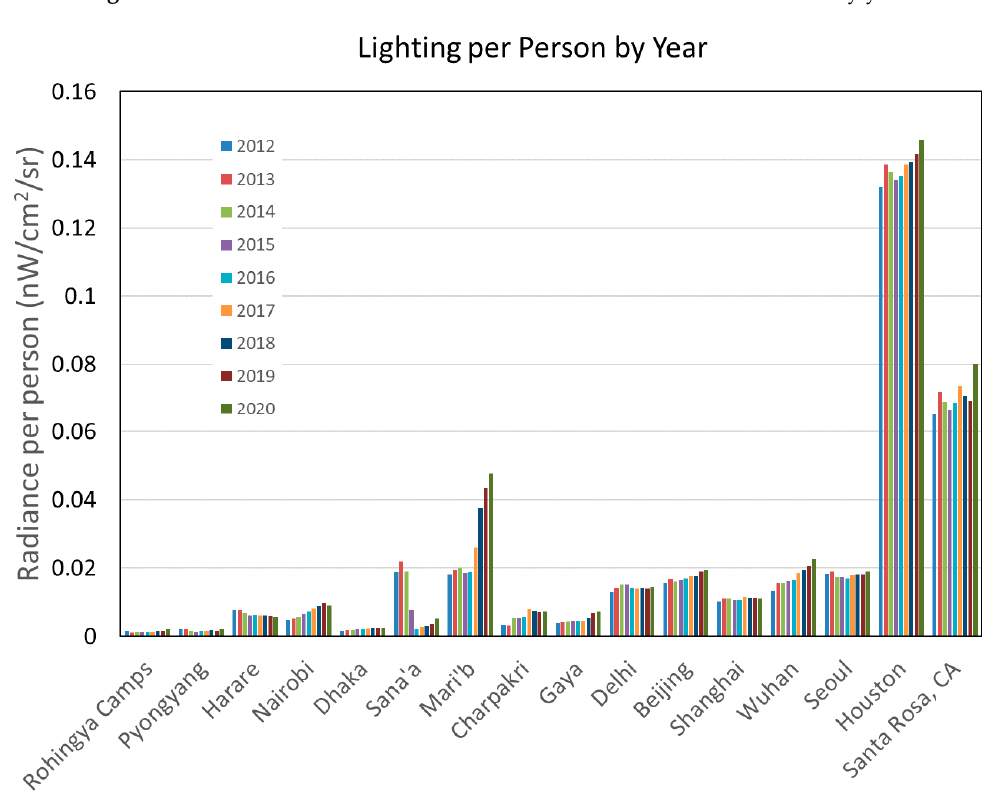
Figure 19. Picket-fence chart of the radiance per person for each of the test sites by year. . Variance: Variance largely tracks the mean radiance. That is to say, in general, the brighter the lights the higher the variance (Figures 20 and 21). The classification accuracy for variance is 68%.